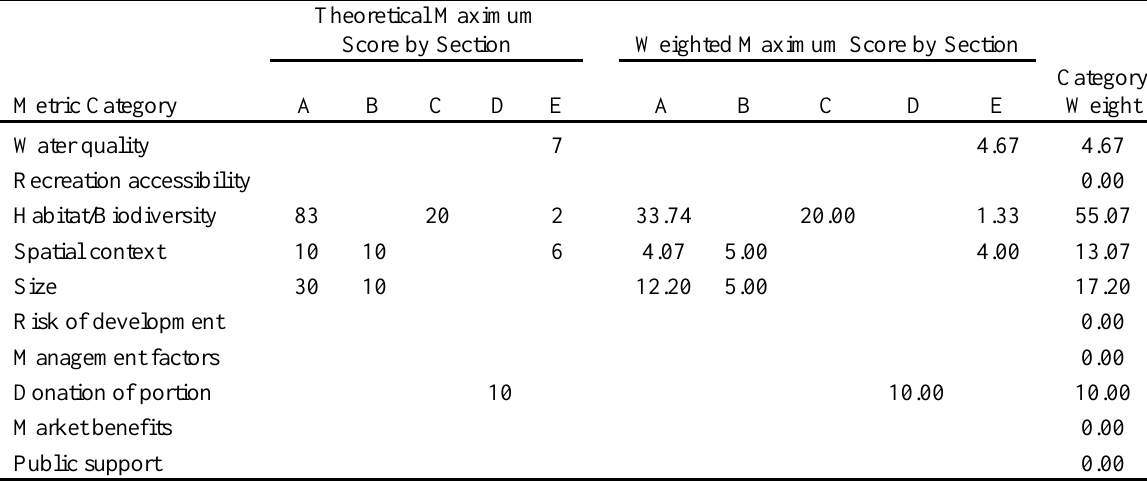
Table A2.2. Estimation of weights under the non-additive Board of Water and Soil Resources Wetland Restoration scoring